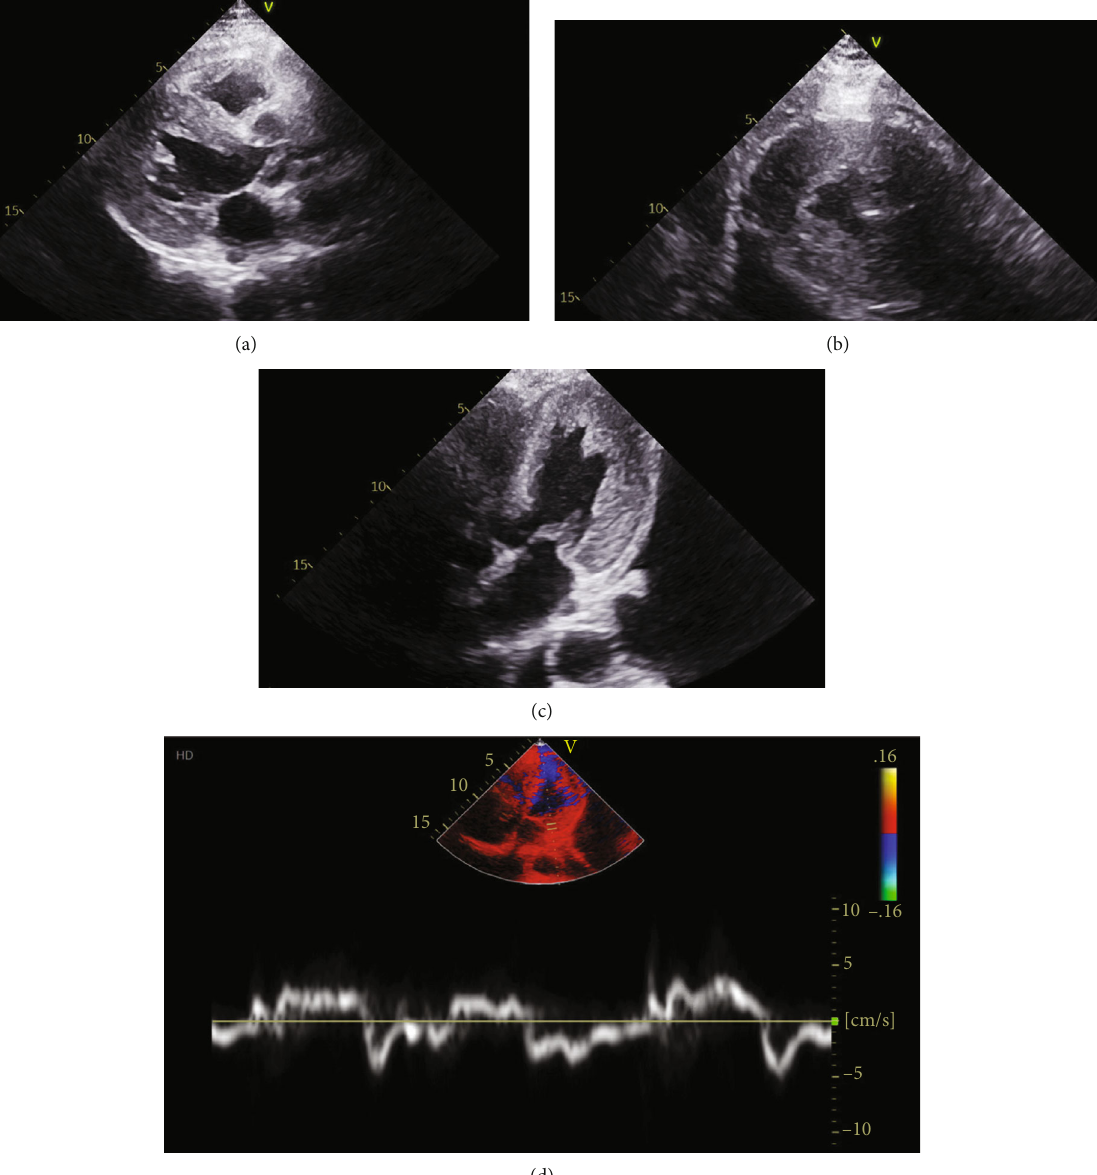
Figure 2: Echocardiogram (a). Parasternal long axis (b). Parasternal short axis (c). Apical two-chamber of left ventricle and (d) tissue Doppler showing severe left ventricular hypertrophy and diastolic